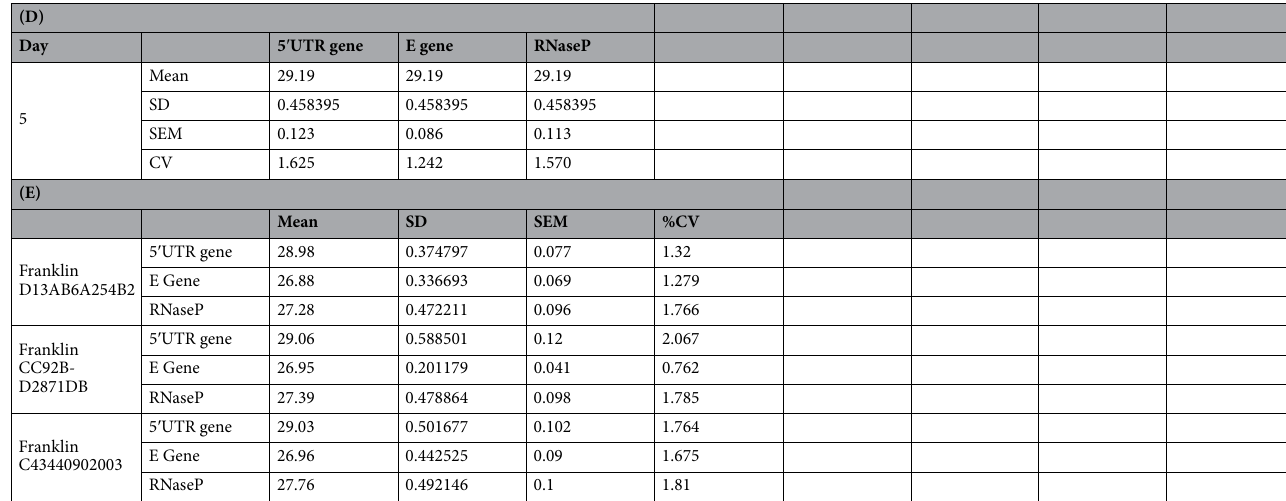
Table 3. Repeatability of Biomeme and Precision Biomonitoring TripleLock SARS-CoV-assay. The M1 Sample Prep Cartridge Kit for RNA 2.0 was used to separately extract RNA from cell culture-amplified SARS-CoV-2. Following RNA extraction, three technicians ran the Biomeme SARS-CoV-2 Test (twice) with eight extracts of the same concentration on three different Franklin three9. The mean and standard error of the mean (SEM) of the Ct values from the runs, in addition to the coefficient of variation (CV, shown in brackets), are shown. Tables show the individual and combined runs of the three technicians across the three Franklin three9 (A), the combined runs of the three technicians across the three Franklin three9 (B), and the combined runs of the three technicians and the three Franklin three9 (C). Separate extractions were conducted for the Precision Biomonitoring SARS-CoV-2 test on five separate days across three thermocyclers, the variation in Ct values was described across the across days (D) and the three Franklin three9 (E).